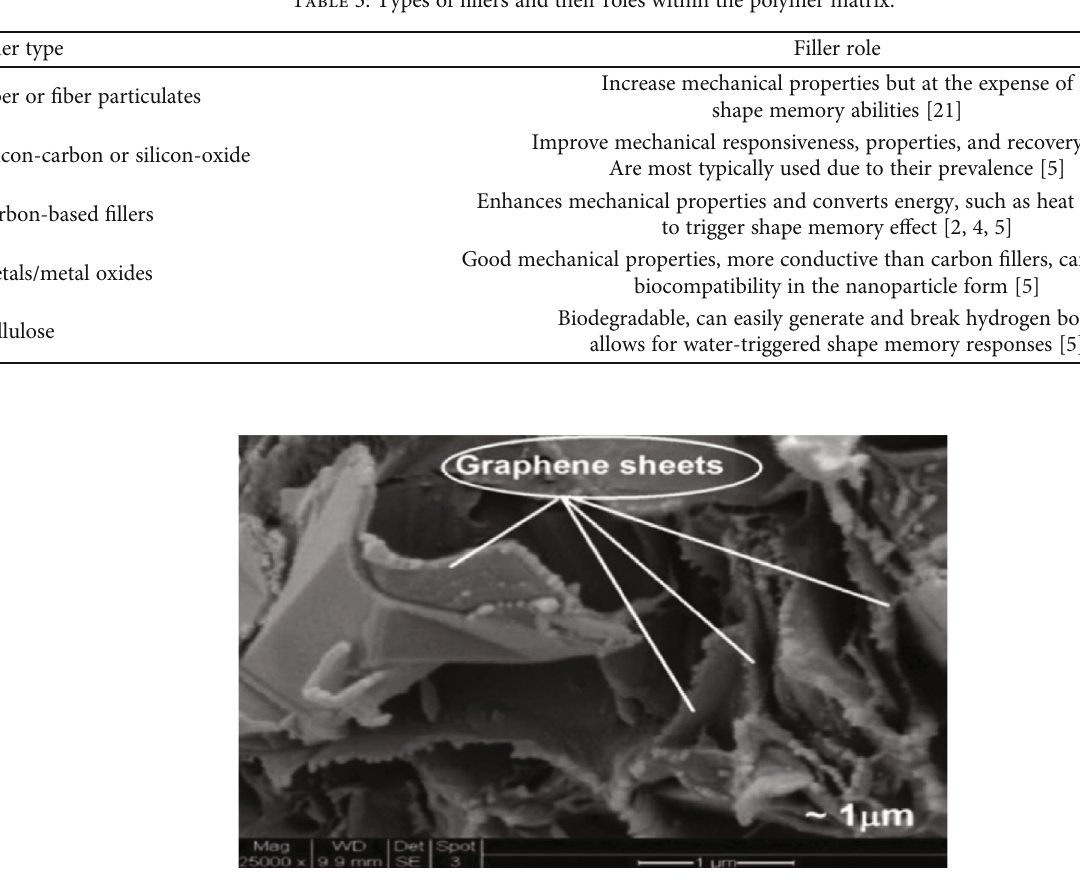
Figure 15: SEM micrograph that shows the cross-sectional morphology of a nanographene sheet-clay composite, coated with polyimide. Courtesy of Longun et al. [41].